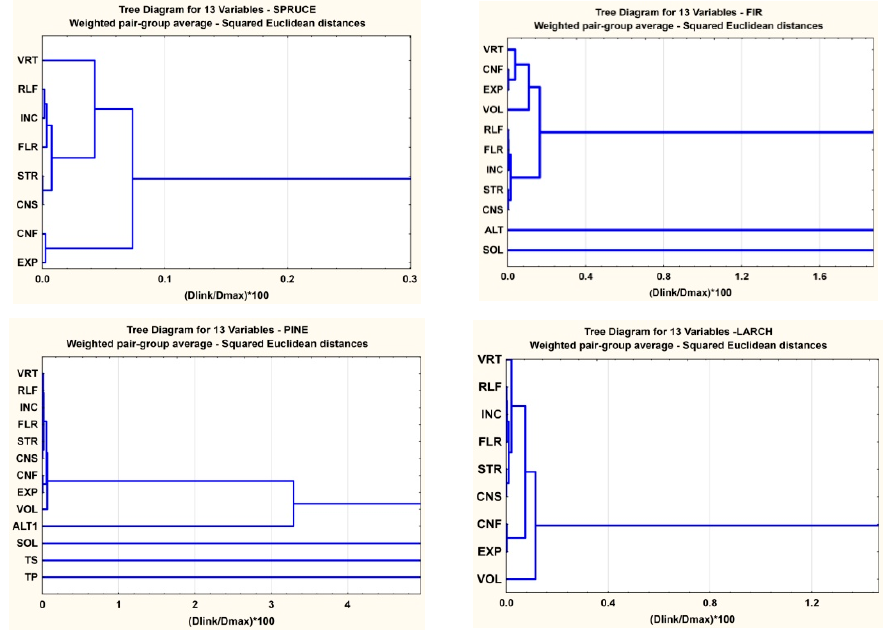
Figure 14. Cluster diagram: weighted pair-group average squared Euclidean distances—details. Fir sequencing is ordered similarly to the spruce sequencing, with three small excep- tions: INC and FLR have altered their places, and ALT has changed with SOL and TS in a circular permutation (Figure 15).